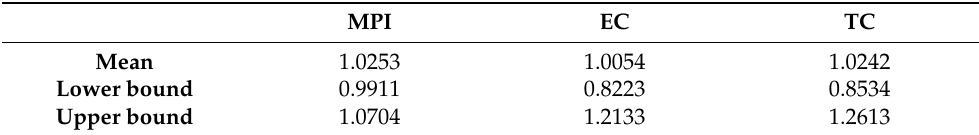
Table 5. Mean 95% confidence intervals for MI, EC, and TC for bootstrap sample.